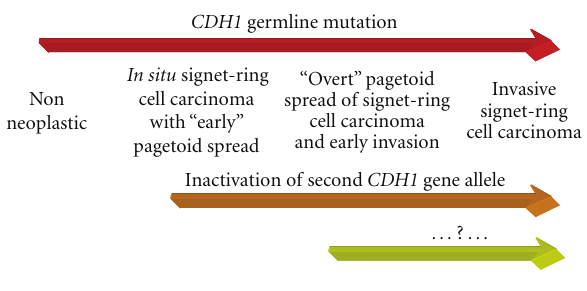
Figure 2: Carneiro’s model for di ff use type GC.